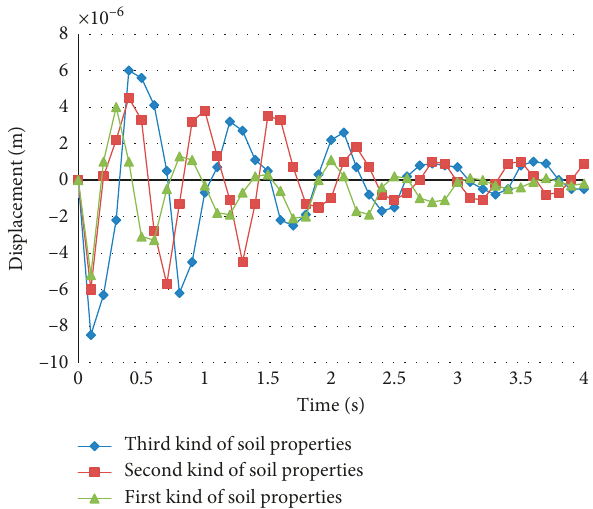
Figure 10: Influence of soil properties on system